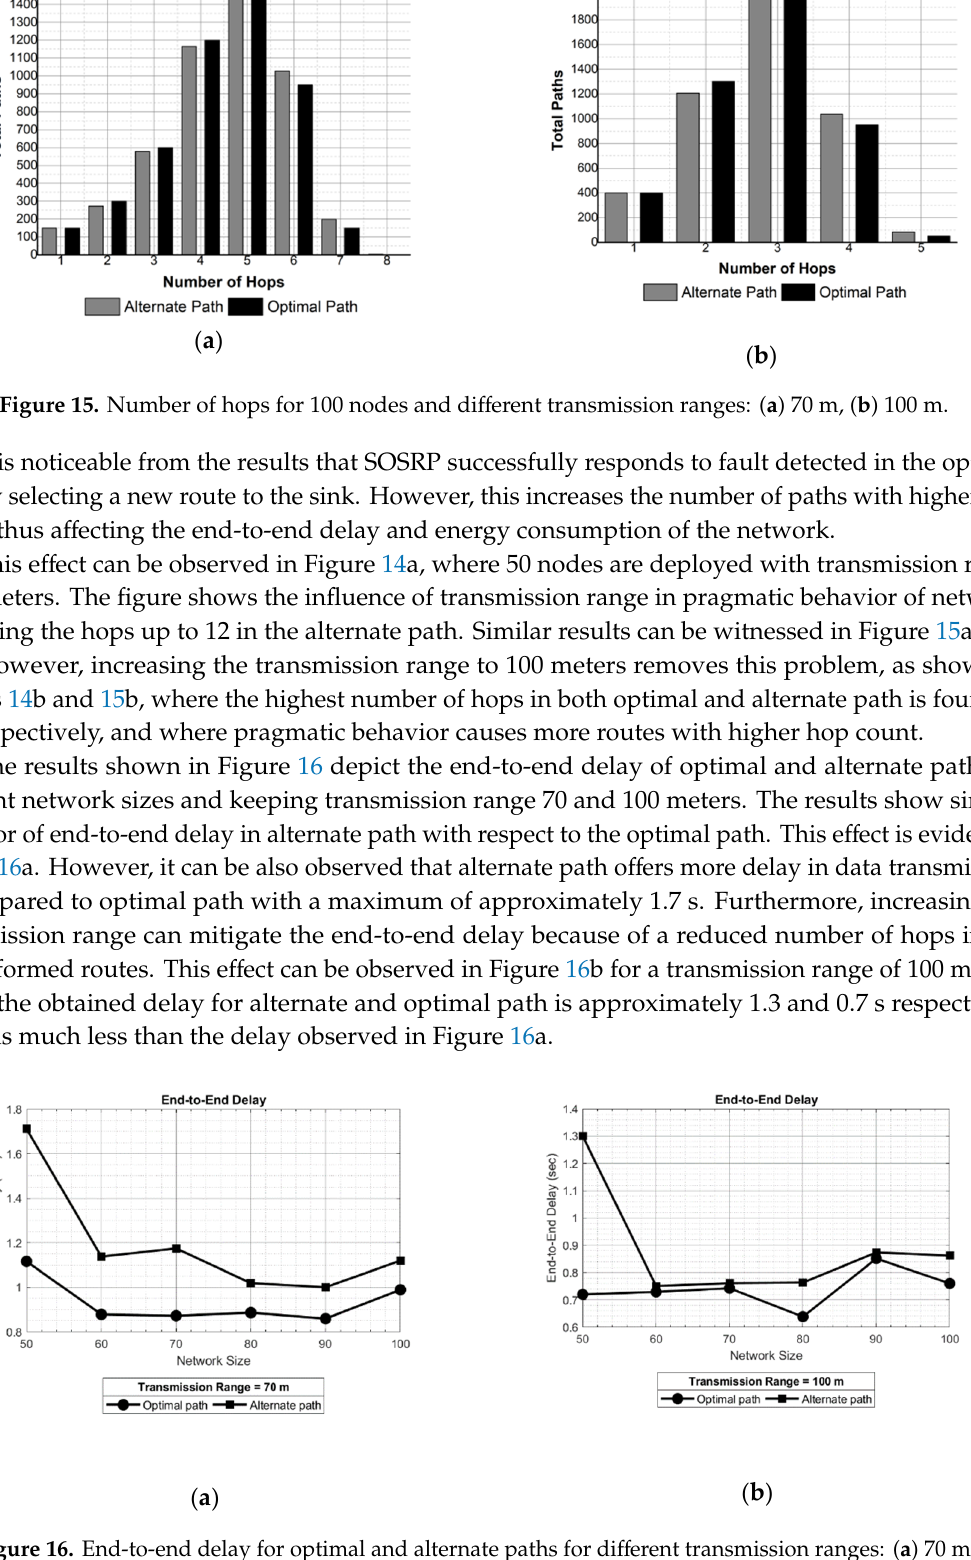
Figure 14. Number of hops for 50 nodes and different transmission ranges: ( a ) 70 m, ( b ) 100 m.